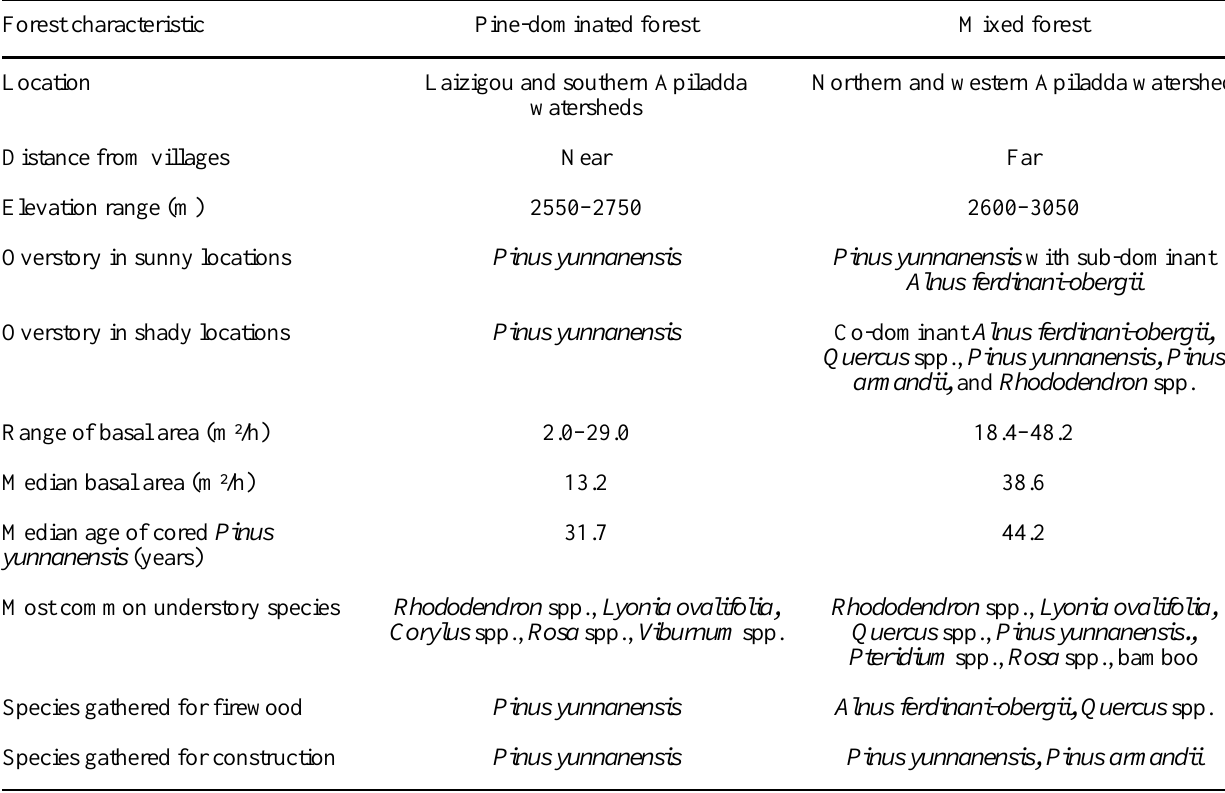
Table 1. Characteristics of the pine-dominated and mixed forest community types. The mixed communities have larger and older trees, greater basal area, more overstory diversity, and less human